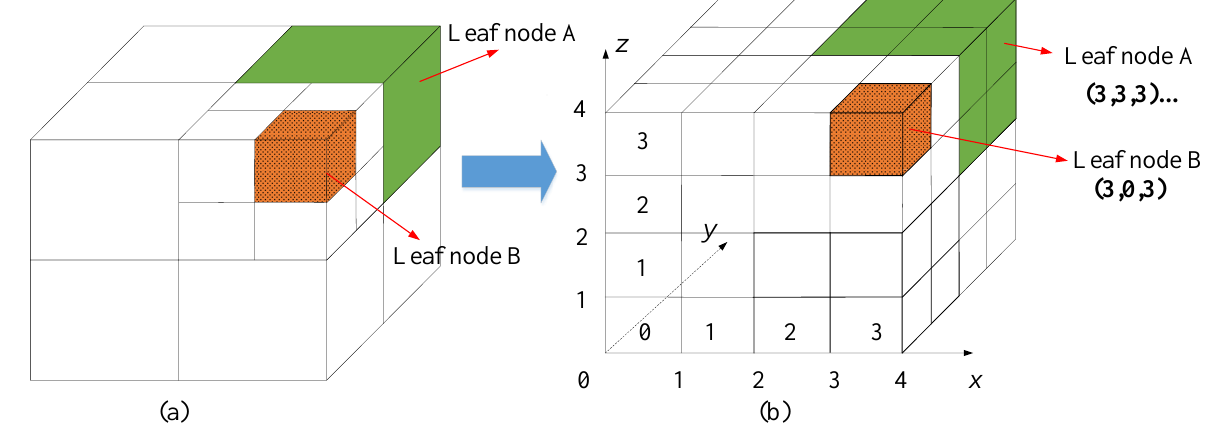
Figure 2. Flowchart of ray marching algorithm.